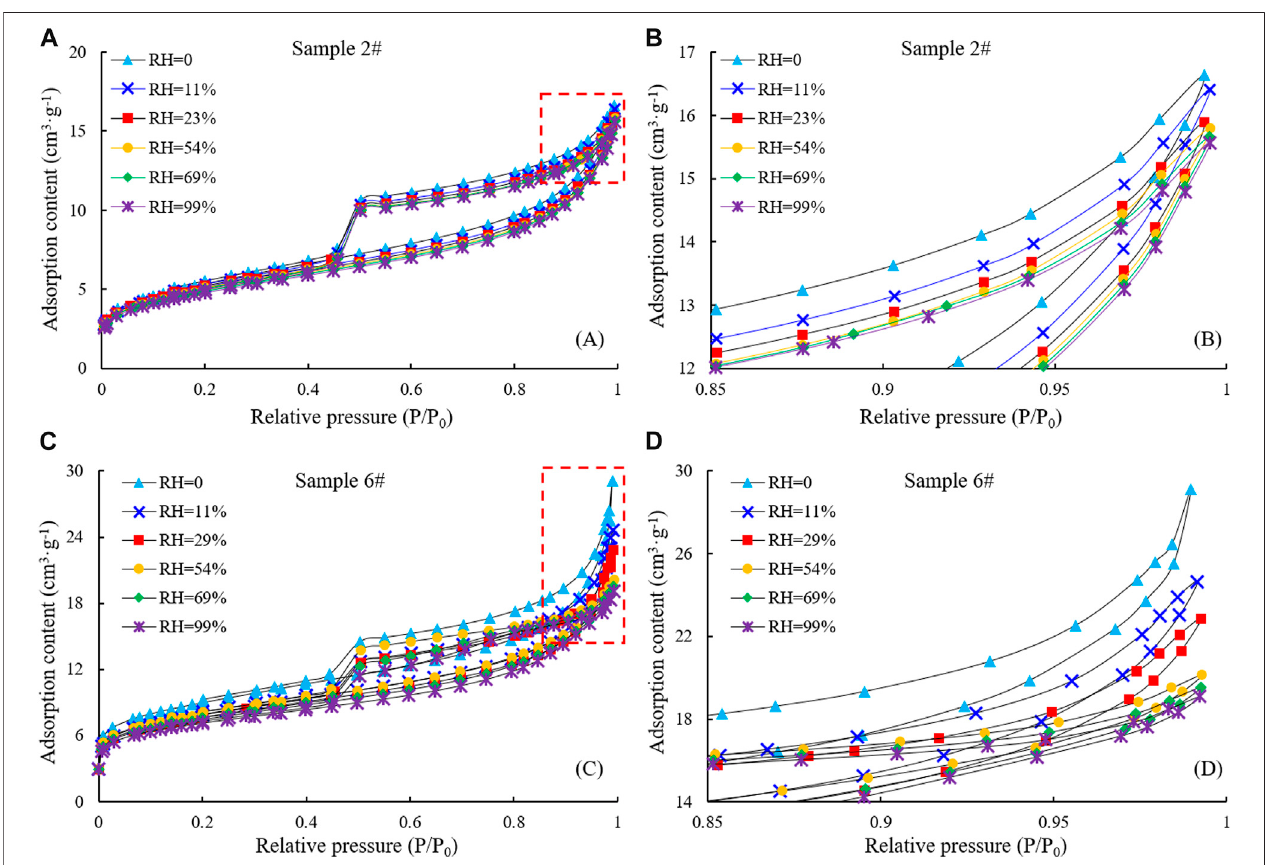
FIGURE 7 | N 2 adsorption/desorption curves of samples #2 and #6 with different humidity (A) . N 2 adsorption/desorption curves of samples #2, (B) . the enlarged view of the part marked by the red dotted line in (A) . (C) N 2 adsorption/desorption curves of samples #6. (D) the enlarged view of the part marked by the red dotted line in (C) .